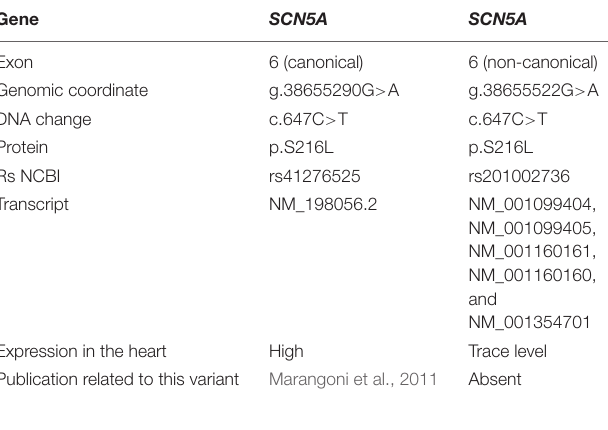
TABLE 1 | Characterization of two genetic variants in the SCN5A gene (based on https://gnomad.broadinstitute.org/gene/ENSG00000183873?dataset=gnomad